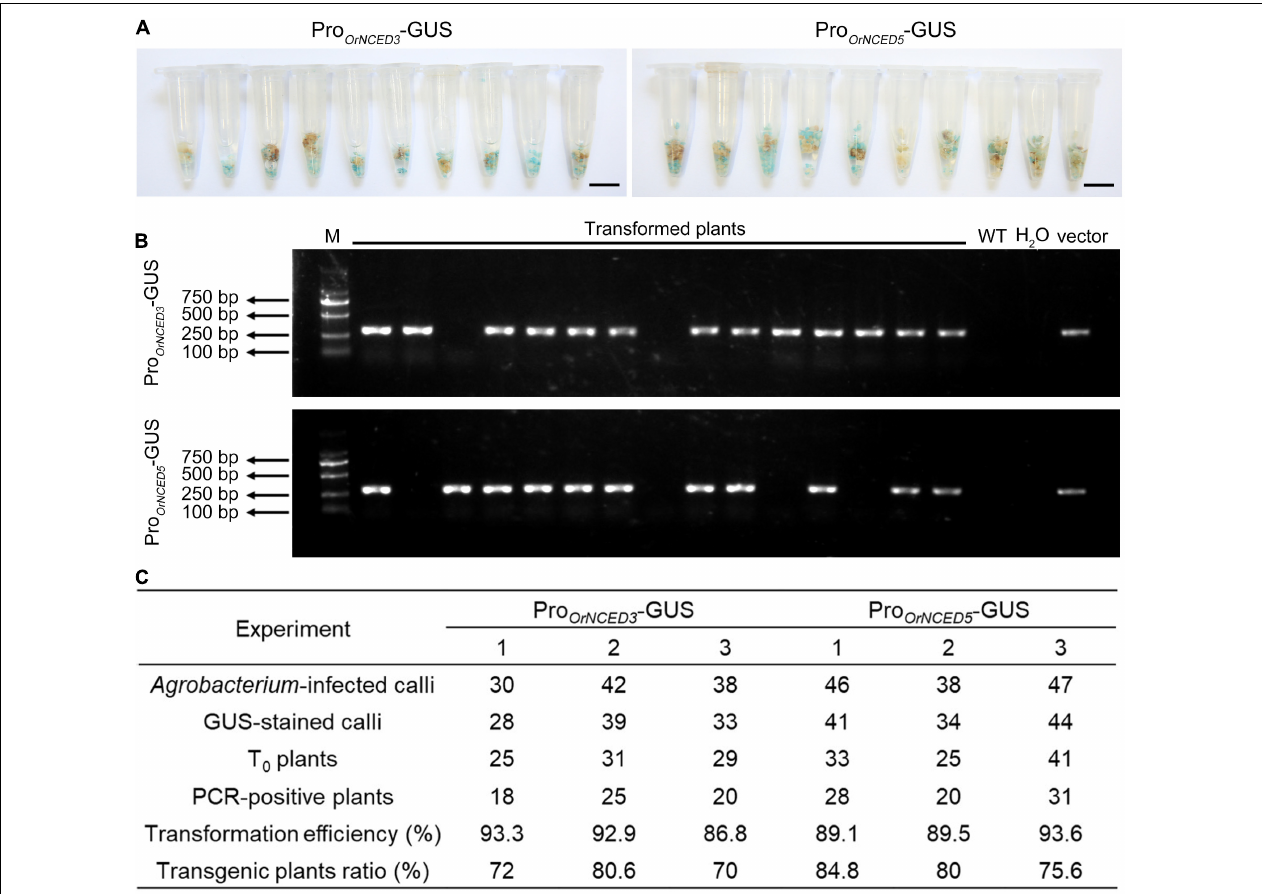
FIGURE 4 | Genetic transformation efficiency of CLCWR. (A) GUS staining of transgenic calli selected by Hygromycin B for three rounds of 15 d each at 28 ◦ C in the dark. Bars = 1 cm. (B) Detection of the vector in transformed plants by PCR using Hyg gene primer. M, marker, DNA ladder 2000. (C) Transformation efficiency and transgenic plants ratio of CLCWR in six experiments. Two GUS reporter vectors were used for transformation. The transformation experiment of each vector was repeated three times. Agrobacterium -infected calli, GUS-stained calli, T 0 plants, and PCR-positive plants were counted in each experiment. Then, the transformation efficiencies and transgenic plants ratios were calculated according to the corresponding